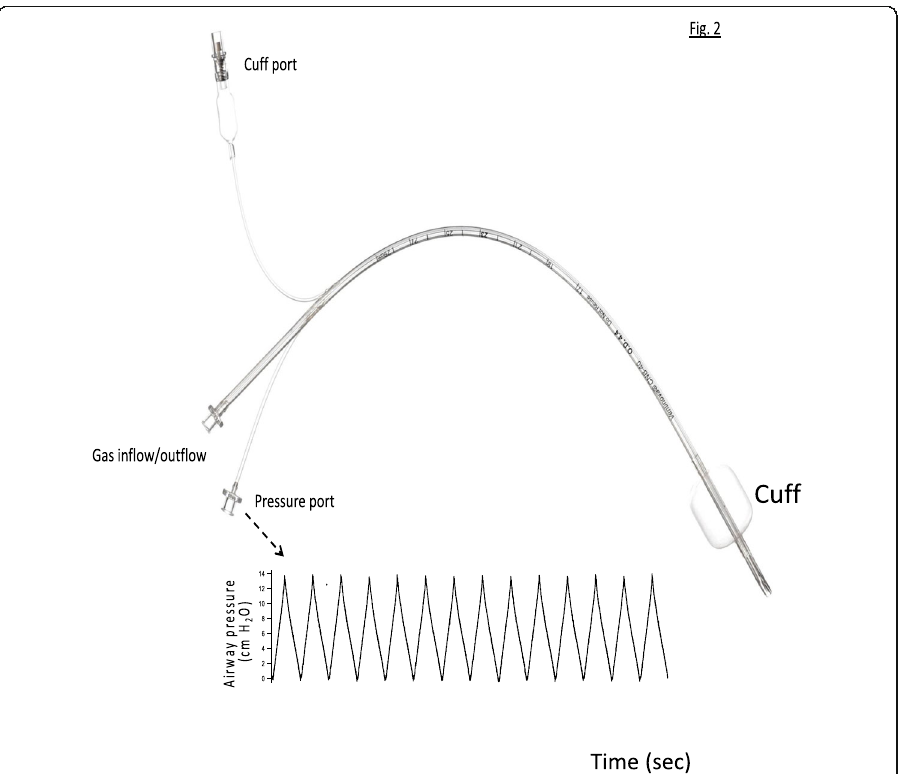
Fig. 1 The Tritube used for expiratory ventilation assistance has three ports on the proximal end. An example of the pressure-time tracing from the airway is shown at the bottom. The end-expiratory pressure has been set to 0 cmH 2